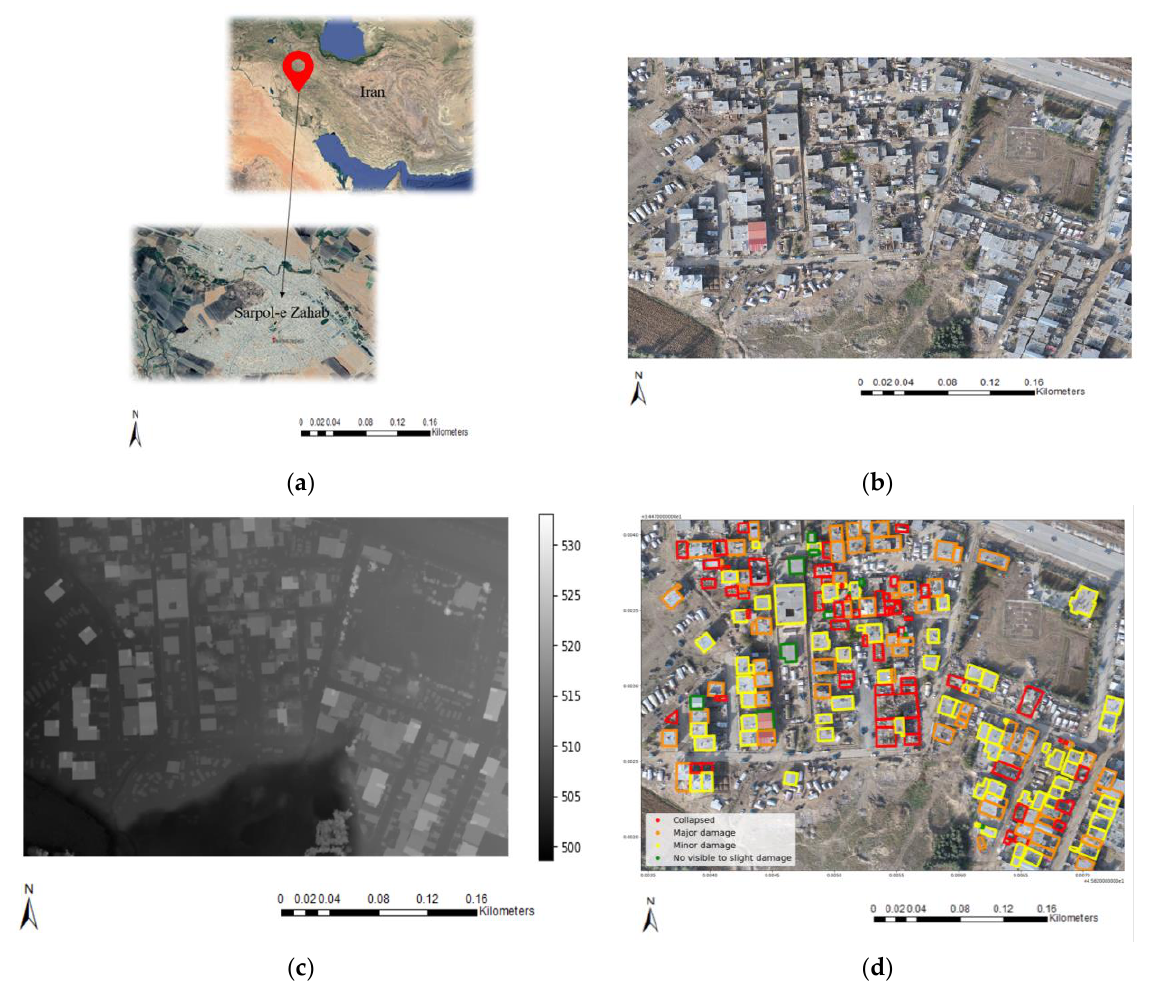
Figure 1. Study area: ( a ) Location map, ( b ) Orthophoto, ( c ) DSM, ( d ) Buildings’ vector map and the corresponding reference damage levels. Table 2. Utilized UAV dataset specification.